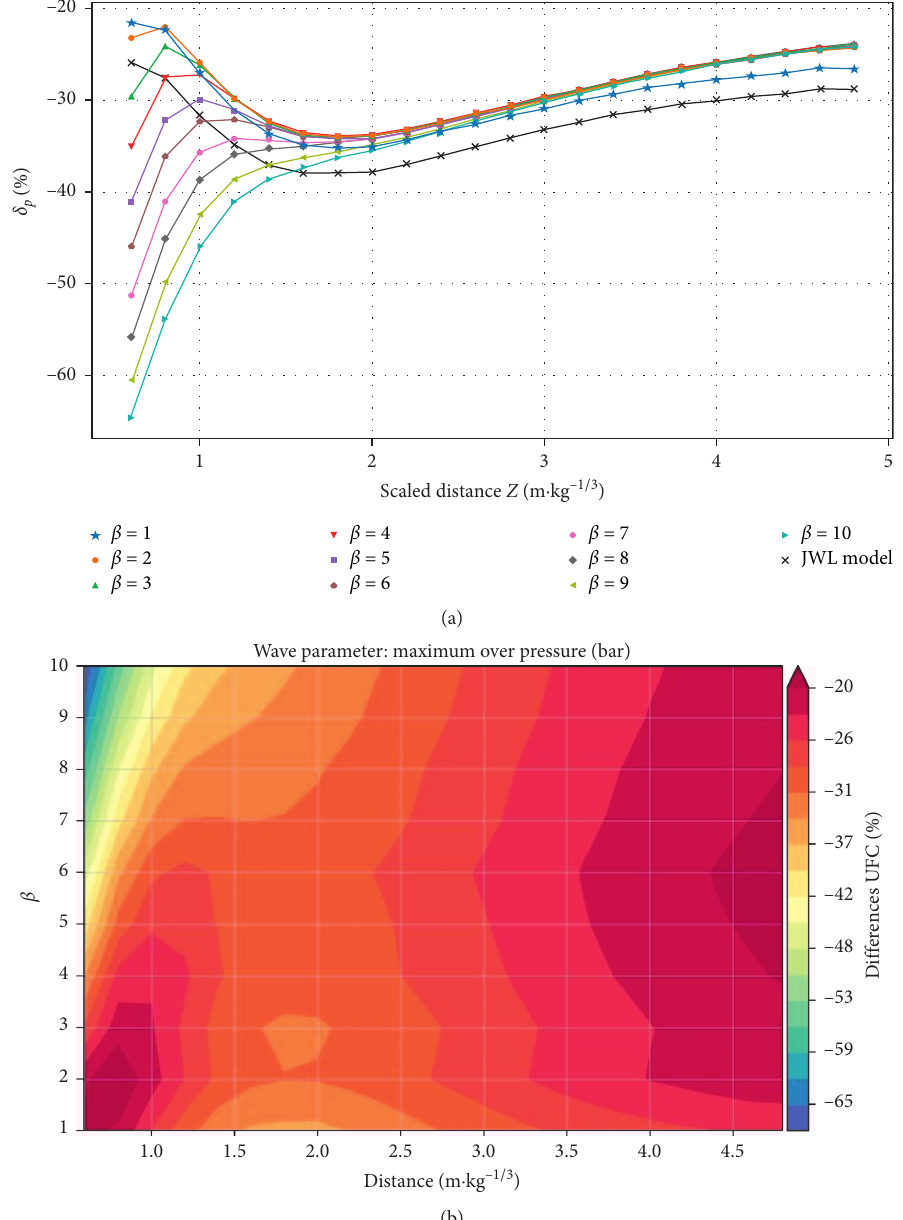
Figure 4: Pressure relative difference δ P with UFC-3-340-2 for all beta models as function of distance (a) or distance and β